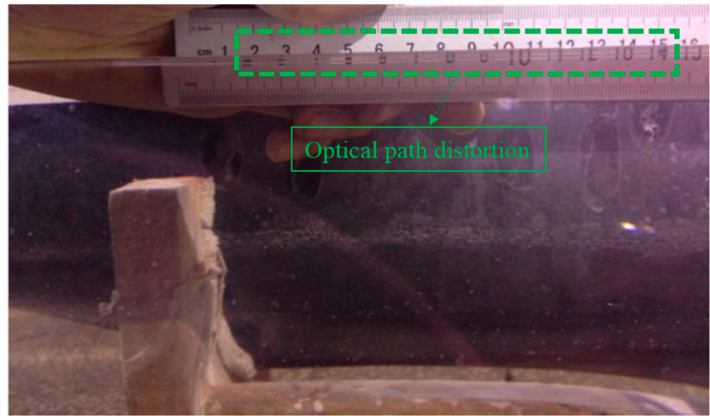
Figure 7. Optical path distortion in practical application.